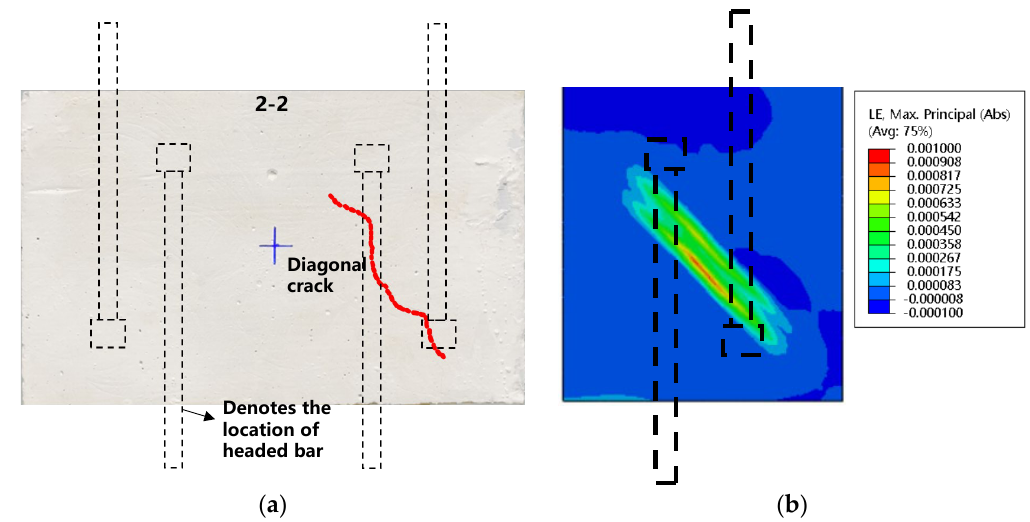
Figure 31. Crack pattern of experimental and numerical observation.